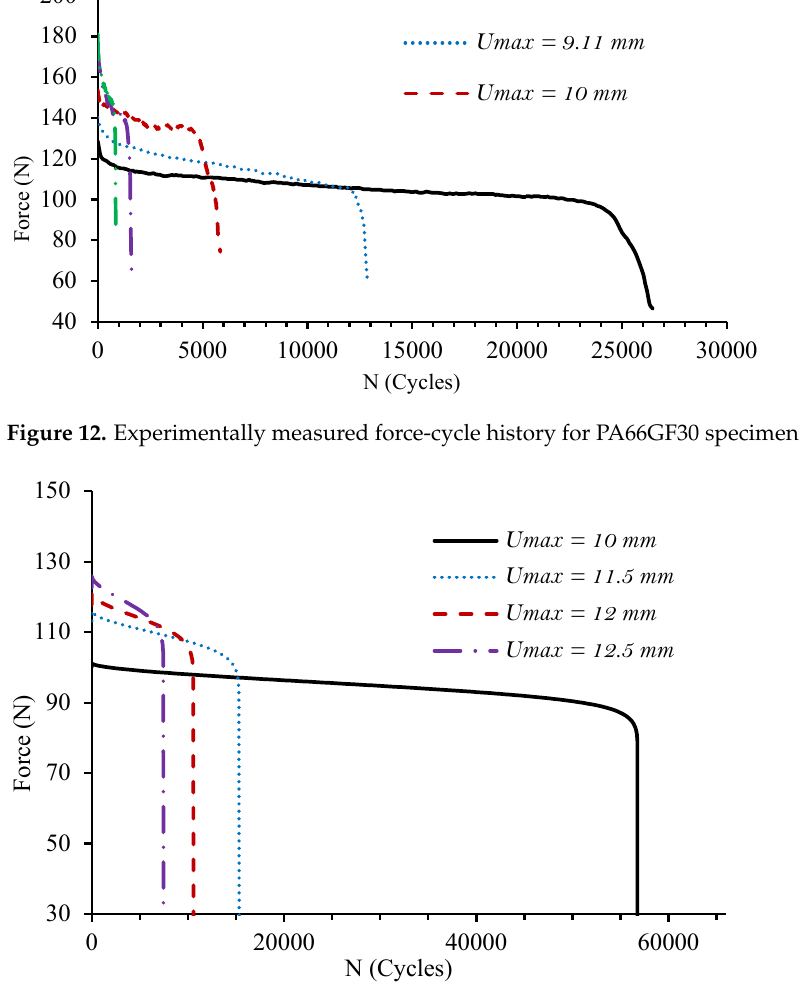
Figure 13. Simulated force-cycle history for PA66GF20 specimens.